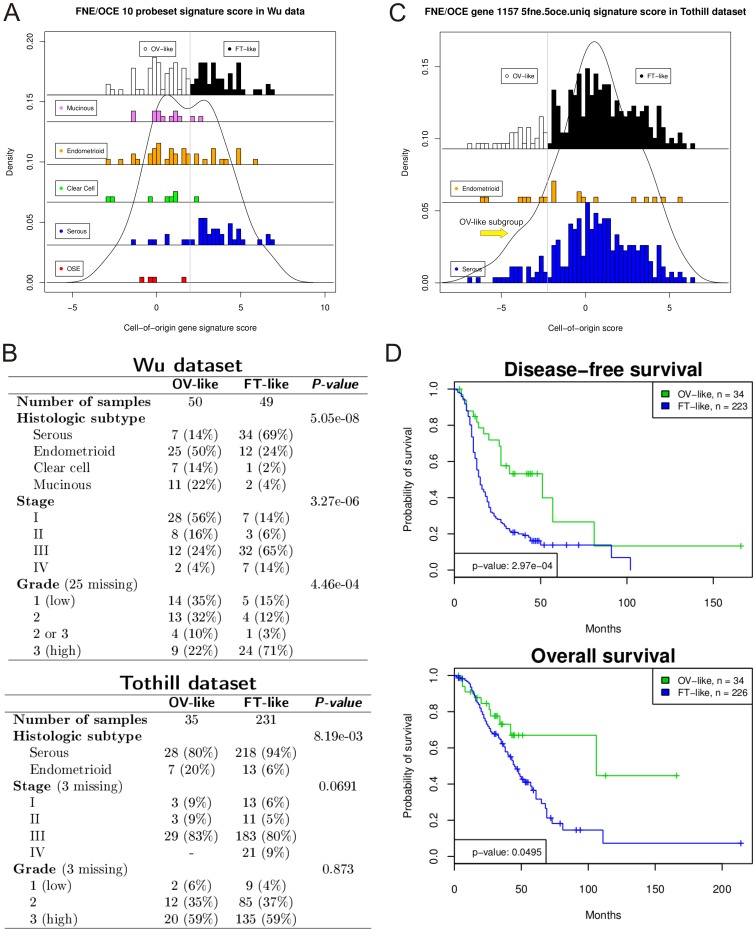
Validation of FNE versus OCE cell-of-origin gene signature in two independent ovarian cancer datasets.
A, Density plot shows a bimodal distribution of signature scores for 99 ovarian tumor samples and four normal OSE scrapings from the Wu et al. dataset. Histograms demonstrate the classification of these samples into normal ovarian epithelial like (OV-like) and normal fallopian tube epithelial like (FT-like) subgroups (top pane), and show the range of signature scores by tumor histological subtype (lower panes). B, Association of the OV-like/FT-like tumor classification in the Wu and Tothill datasets with clinical characteristics (P-values from logistic regression (grade, stage as ordinal variables) and Fisher’s Exact test (histological subtype)). C, Density plot demonstrates a slight left skewing of the signature scores in the Tothill et al. dataset which suggests a small subpopulation (arrow) of OV-like tumors. Histograms demonstrate the distribution of signature scores in endometrioid and serous tumors. D, Kaplan-Meier plots demonstrate significant differences in the disease-free survival and overall survival between OV-like and FT-like subgroups in the Tothill dataset (univariate P-values from the log-rank test are displayed).